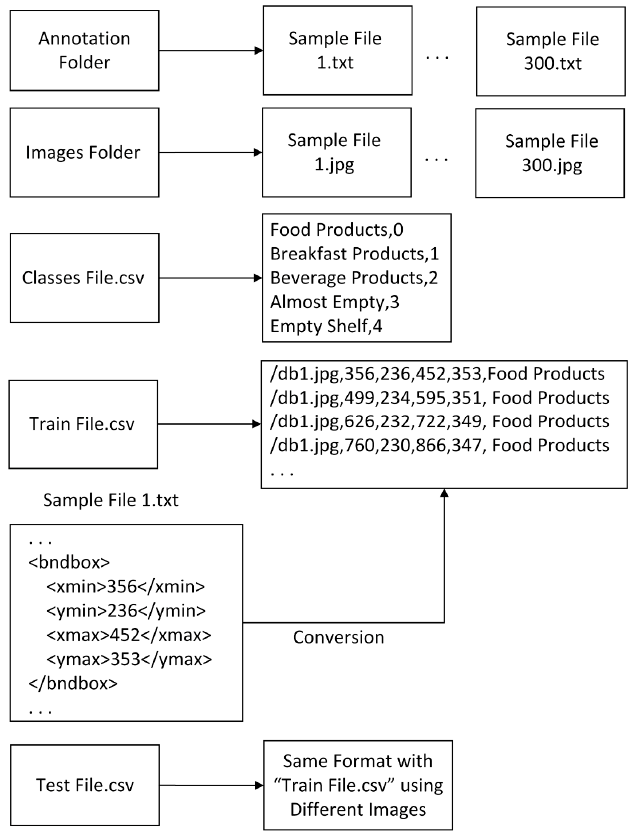
Figure 9. RetinaNet sample file structure and conversion details.